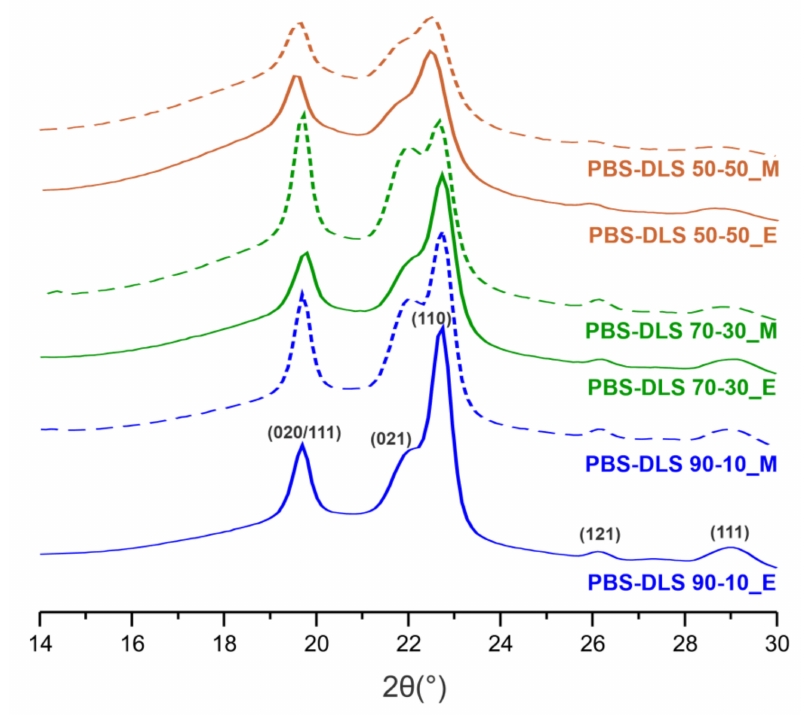
Figure 13. X-ray diffraction pattern of PBS-DLS